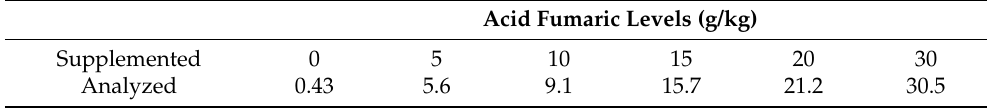
Table 2. Fumaric acid content of experimental